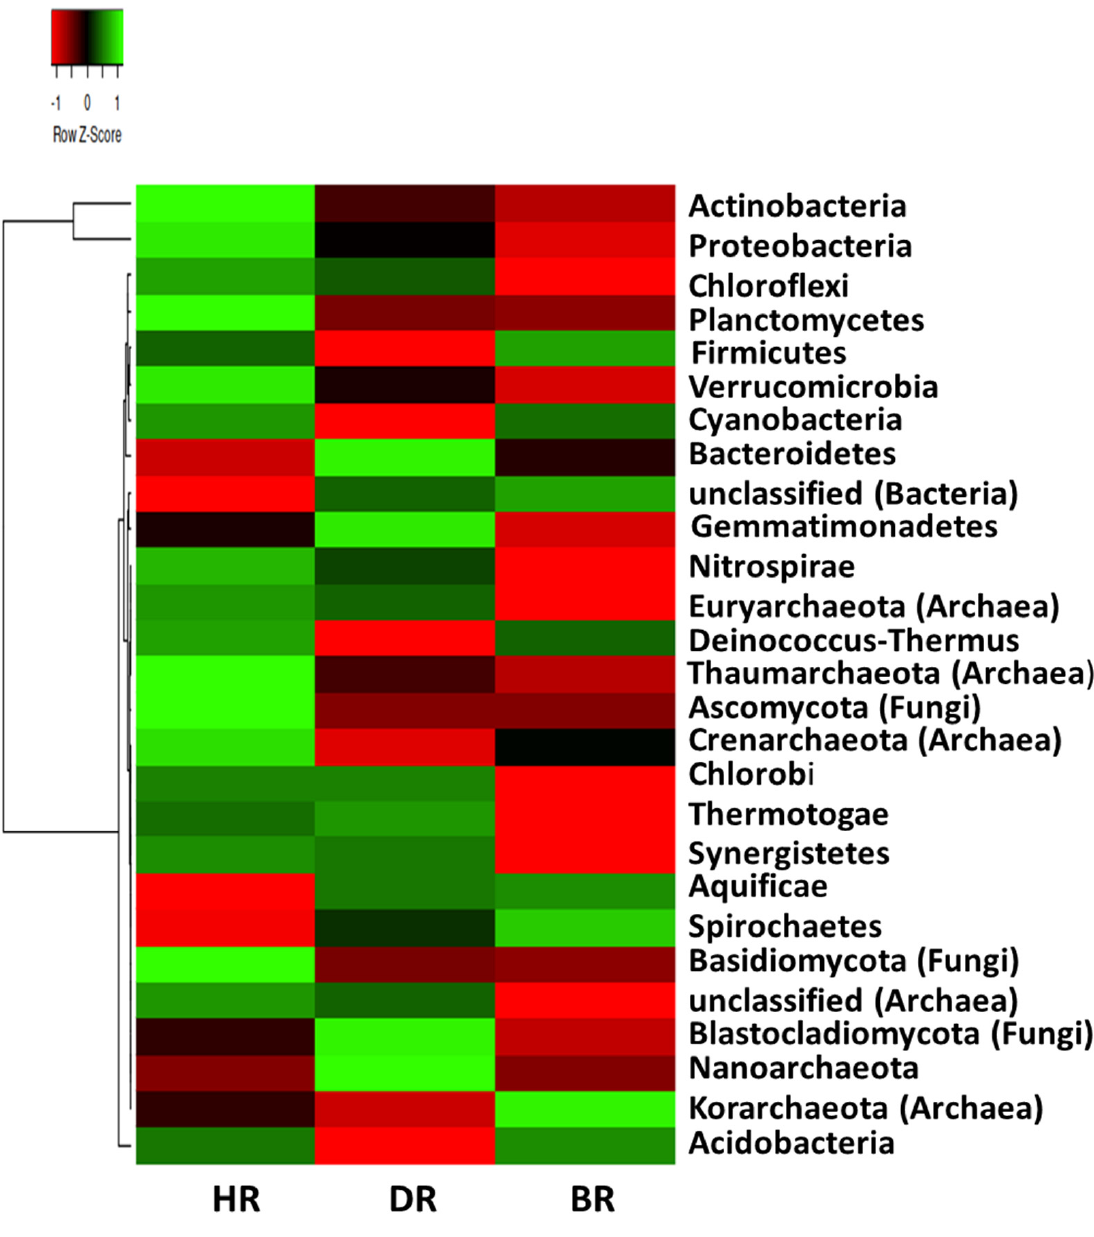
Figure 1. Phyla heatmap of soil microorganism affiliated with the tomato plants. Each plot with particular color functioned as a saturation gradient employing the mean value with a z-score. HR = rhizosphere soil of healthy tomato plant; DR = rhizosphere soil of diseased tomato plant; and BR = bulk soil obtained from the soil without tomato plantation.